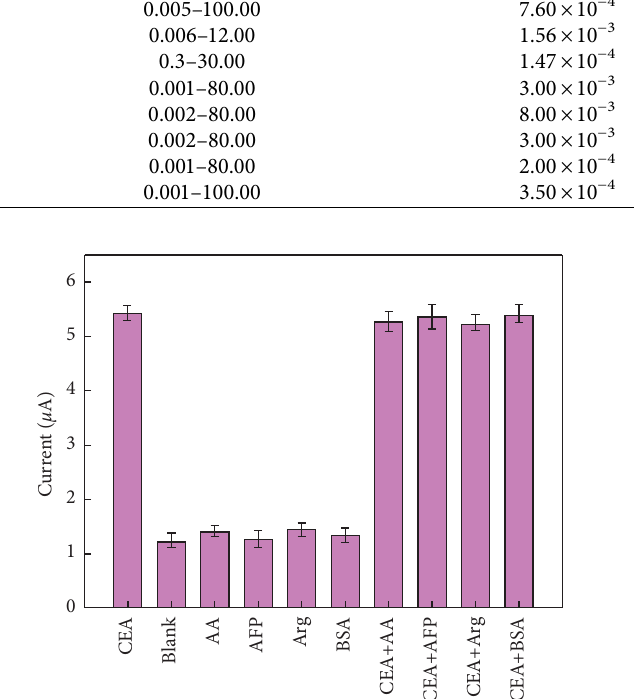
Figure 5: Te specifcity of the CEA immunosensor. Error bars � SD ( n � 5).